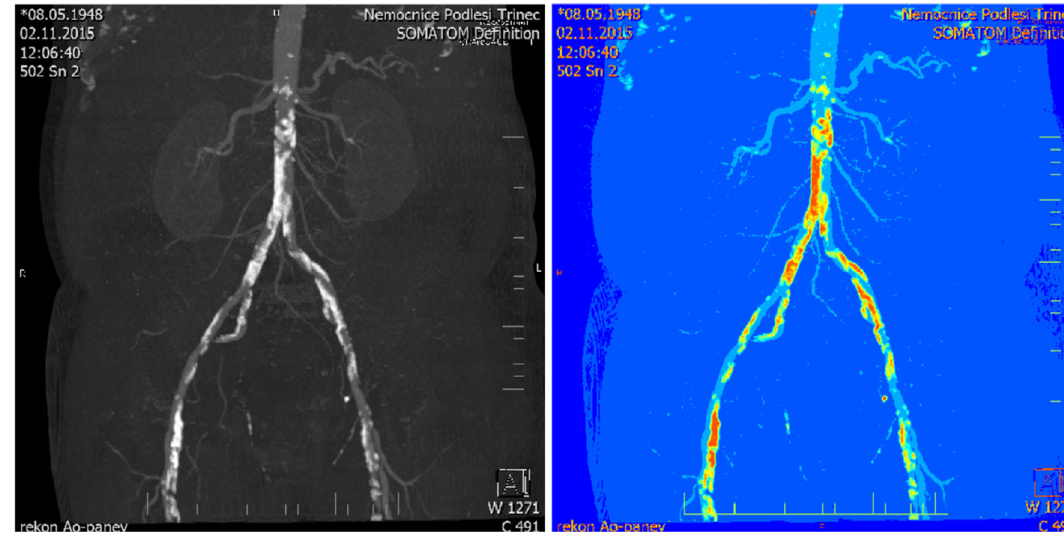
Fig. 3 Native CT angiography record (left), output of the segmentation model with 8 segmentation classes (right)